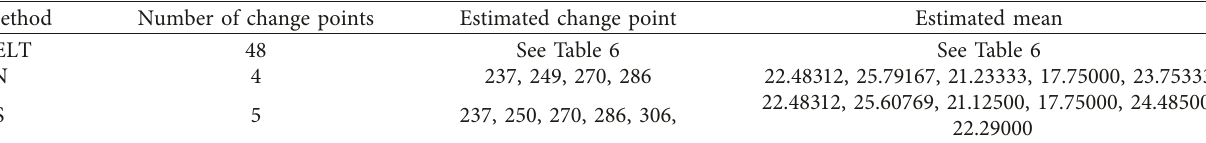
Table 5: Number of change points for the mean of maximum temperature.